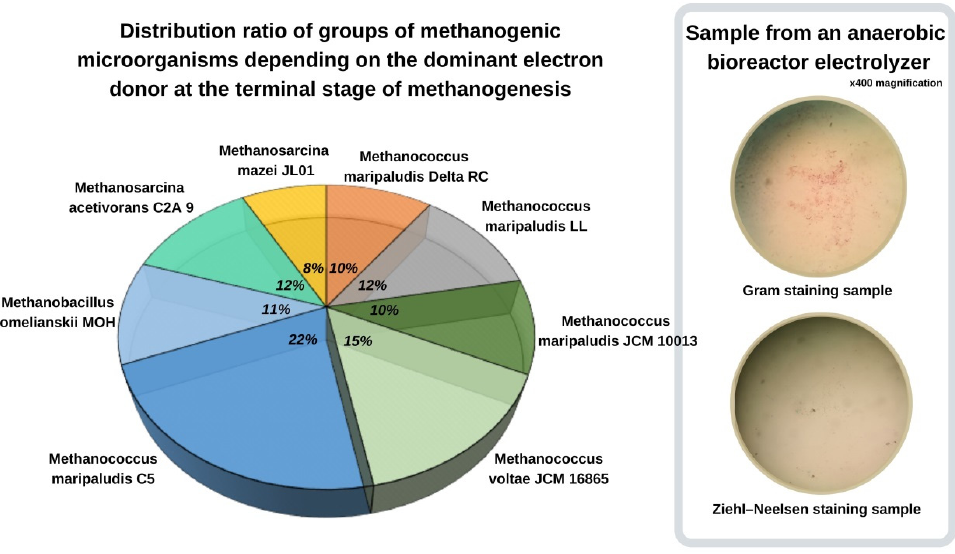
Figure 5. Modeling the composition of methanogens under the influence of an electric current during anaerobic digestion.